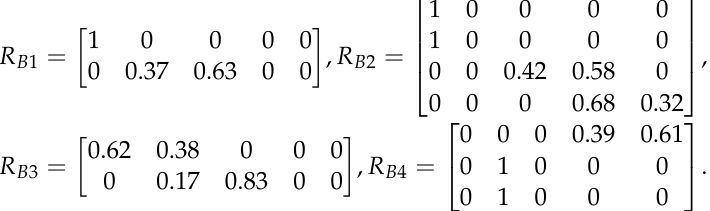
Figure 3. Weight calculation results of Tufang River assessment index